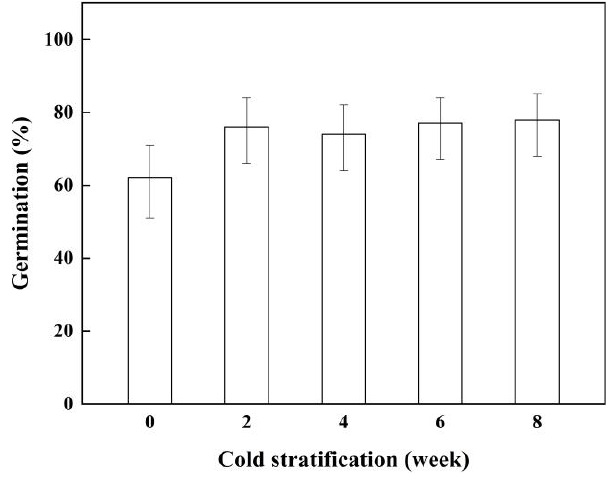
Figure 3. Germination percentage (±95% binomial confidence intervals) of P. kansuensis seeds incubated with different cold stratification treatments in 12 h light/12 h dark at 10/25 °C.